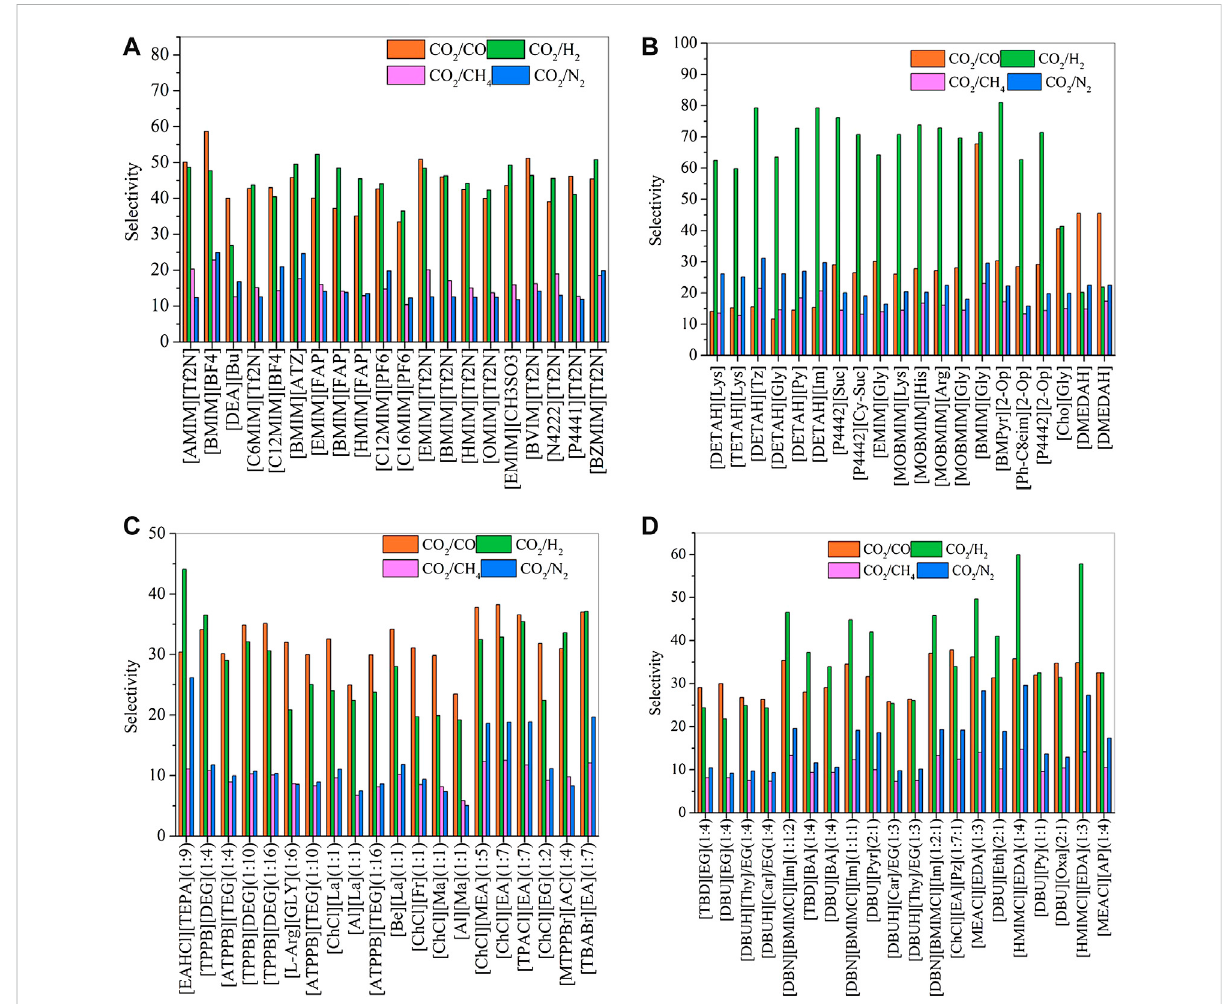
FIGURE 2 Selectivities of CO 2 /CO, CO 2 /H 2 , CO 2 /CH 4, and CO 2 /N 2 in physical-based ILs (A) , chemical-based ILs (B) , physical-based DESs (C) and chemical-based DESs (D) predicted by the COSMO-RS model at 298.15